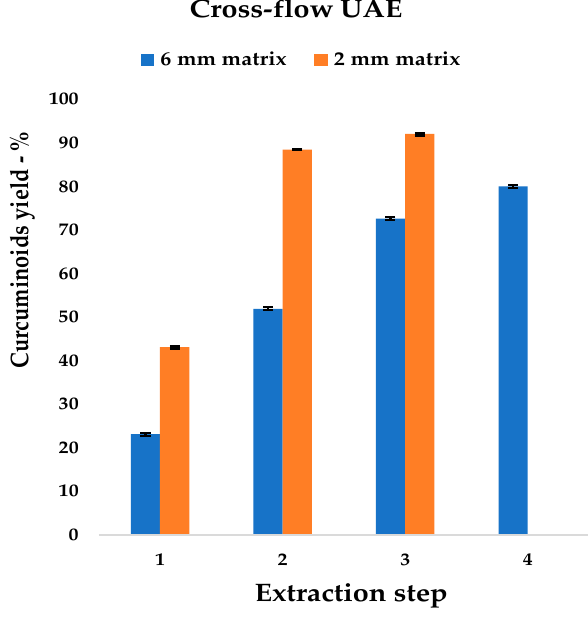
Figure 7. Cross-flow trend for 6 and 2 mm particle sizes.